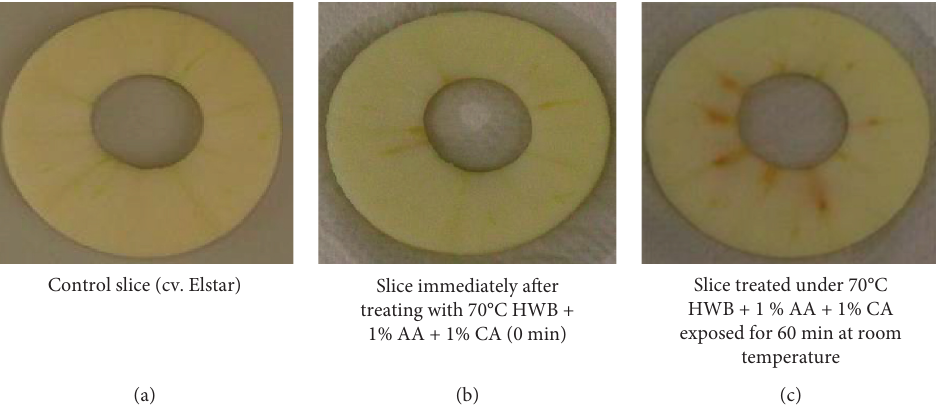
Figure 1: Illustration of the appearance of fresh-cut apple slices at different conditions: (a) control slice; (b) slice immediately after treating with 70 ° C HWB+1% AA+1% CA; and (c) 70 ° C HWB+1% AA+1% CA treated slice exposed for 60min at room